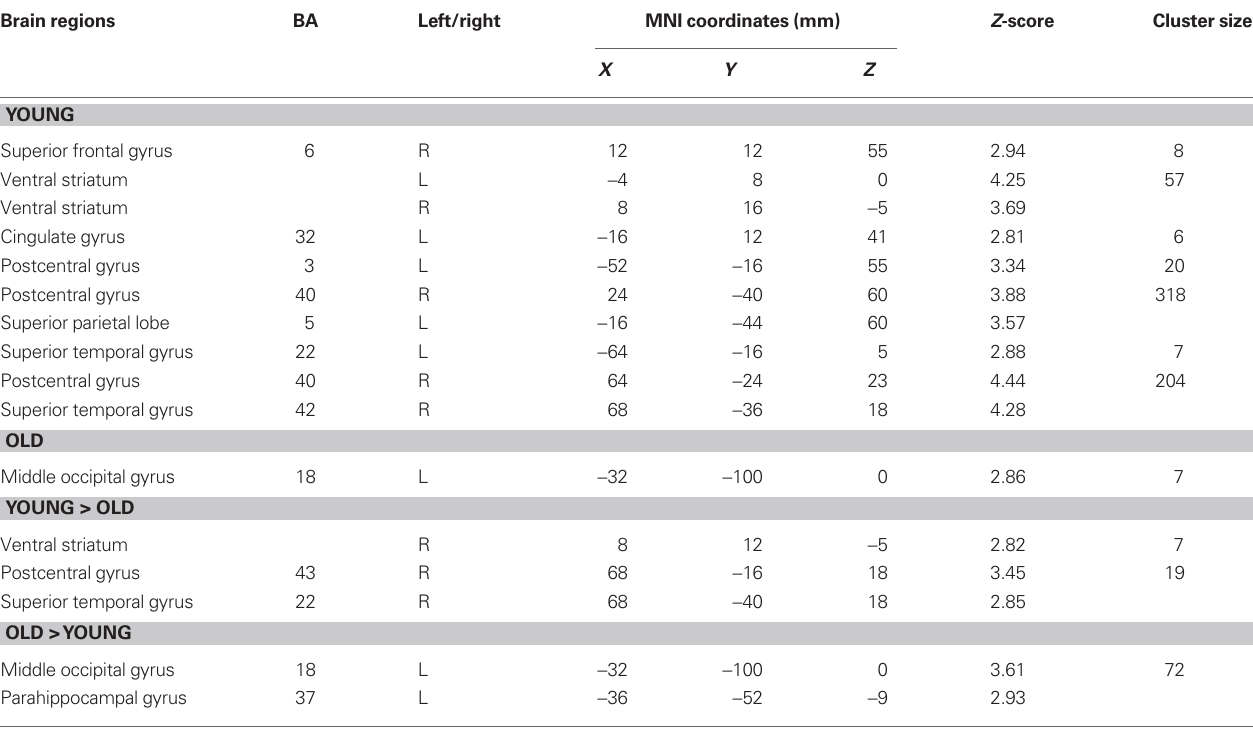
Table 4 | Reward processing during “learned” vs. “search”